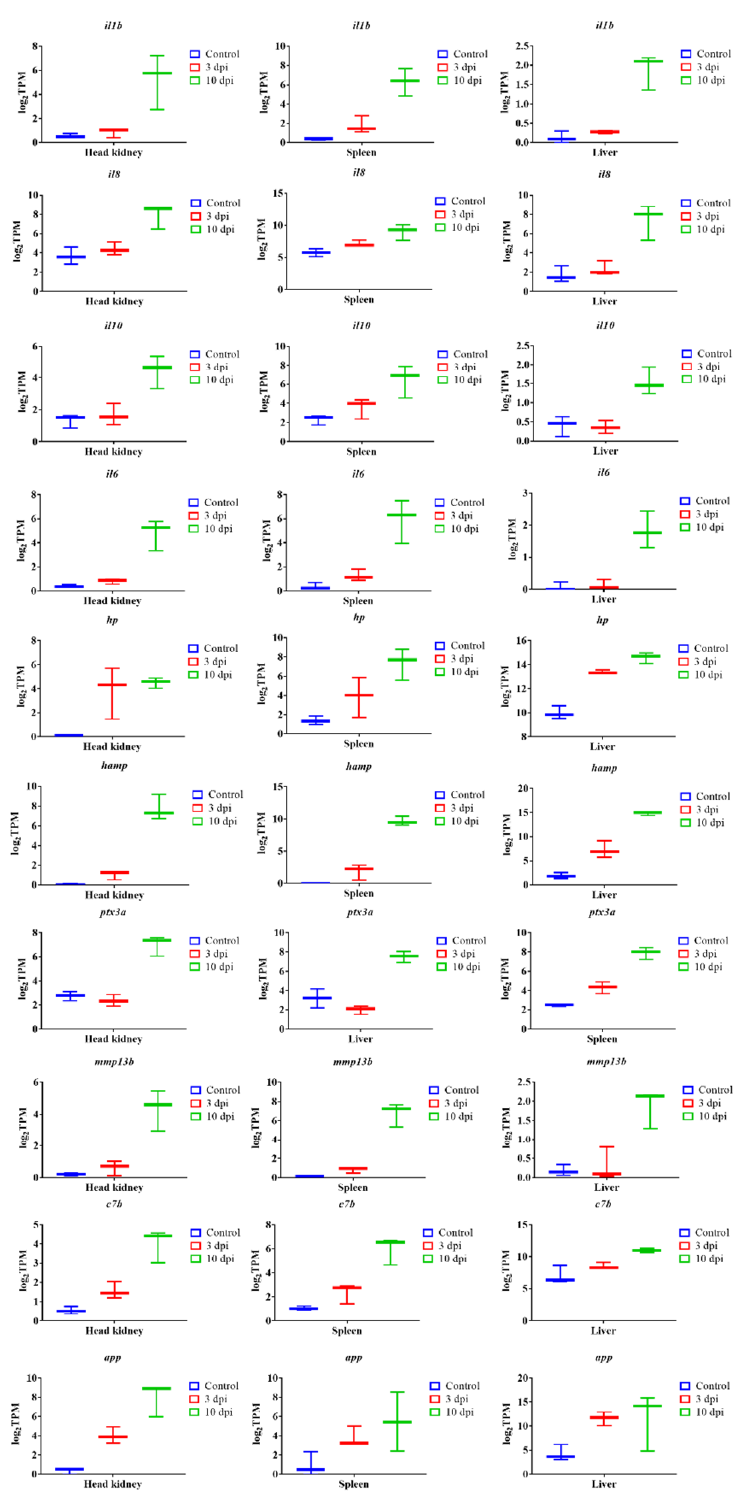
Figure 7. Most significant DEGs in all organs studied after A. salmonicida infection in lumpfish. Bar plots represent the expression pattern (log 2 TPM) of interleukin-1 beta (il1b), interleukin-8 (il8), interleukin-10 (il10), interleukin-6 (il6), haptoglobin (hp), hepcidin (hamp), pentraxin-related protein PTX3 (ptx3), collagenase (mmp13b), complement component C7 (c7), and amyloid protein A (app).